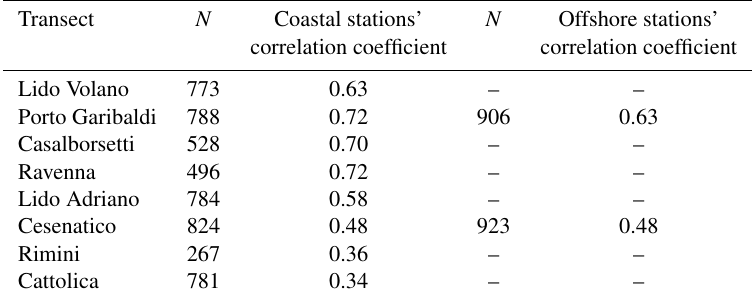
Table 4. Pearson’s correlation values between the in situ TRIX and the model TRIX ( p value < 0.01 for all transects). All the transects are comprised of coastal stations (up to 10km distance from the coast, Fig. 1), while two transect (Porto Garibaldi and Cesenatico, Fig. 1) contained offshore stations (at 20km distance from the coast). The number of records ( N ) available for each transect is listed.